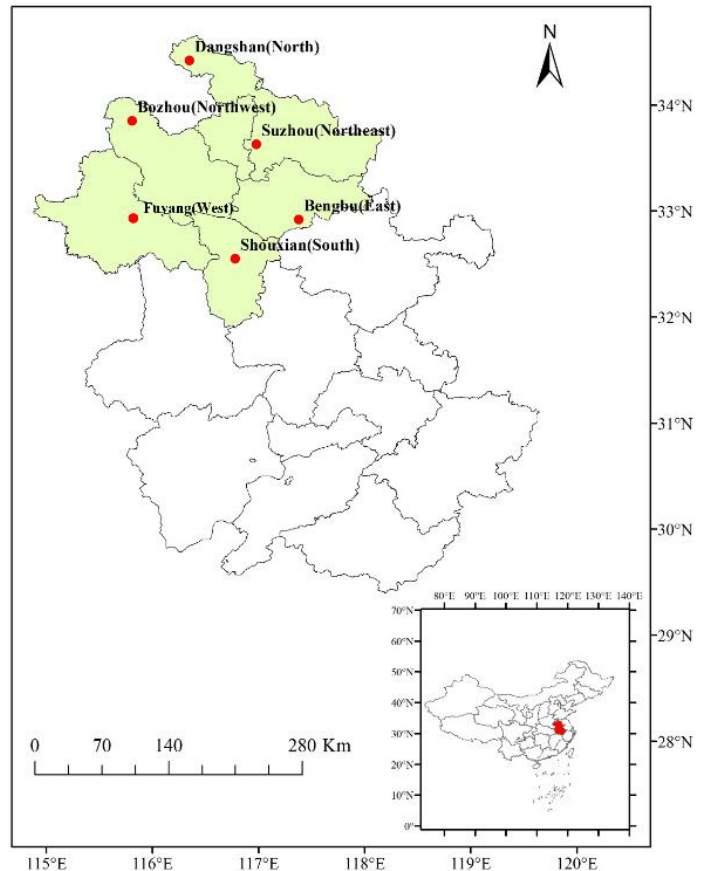
Figure 1. The locations of Shouxian (south, 116.78 ◦ E, 32.55 ◦ N), Bengbu (east, 117.38 ◦ E, 32.92 ◦ N), Fuyang (west, 115.82 ◦ E, 32.90 ◦ N), Suzhou (northeast, 116.98 ◦ E, 33.63 ◦ N), Bozhou (northwest, 115.78 ◦ E, 33.85 ◦ N), and Dangshan (north, 116.35 ◦ E, 34.42 ◦ N) on Huaibei Plain, North Anhui Province, China.